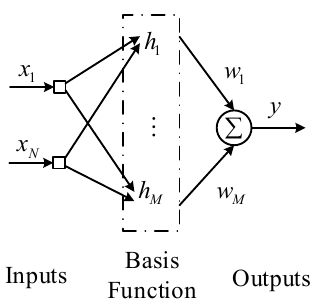
Figure 3. The RBF neural network structure.